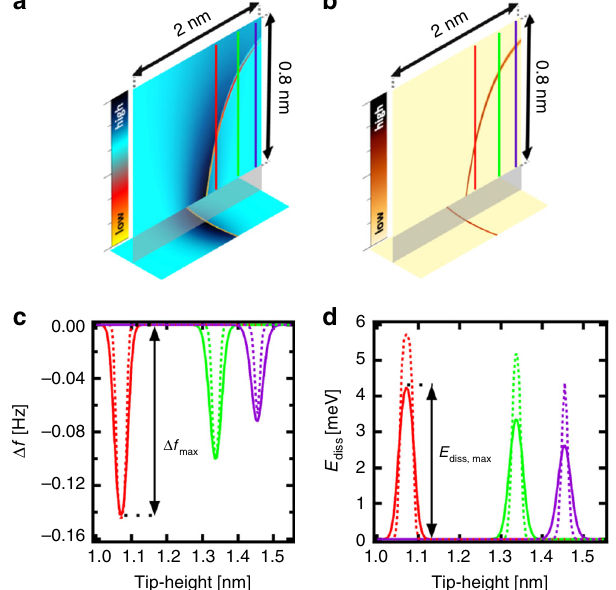
Fig. 4 Results of the simulations. a A simulated frequency shift x-z image of the singularity line (once positively charged molecule). The vertical cut is 2 × 0.8 nm 2 . b The simulated dissipation x-z image of the singularity line (once positively charged molecule). The vertical cut is 2 × 0.8 nm 2 with a gap of 0.1 nm between the base image and perpendicular image of the singularity line. c Calculated Δ f ( z ) spectroscopies for three different cuts through the singularity feature corresponding to three experimental Δ f ( z ) curves, see Fig. 2i. The solid line is calculated for T = 5 K and dashed lines correspond to T = 1.2 K. The curves were calculated along the paths highlighted in a and b . d Calculated E diss ( z ) spectroscopies for three different cuts through the singularity line, along the same paths as in c , corresponding to three experimental E diss ( z ) curves, see Fig. 2j. The solid line is calculated for T = 5 K and the dashed lines correspond to T = 1.2 K. The amplitude of tip oscillation was set to 40 pm in both